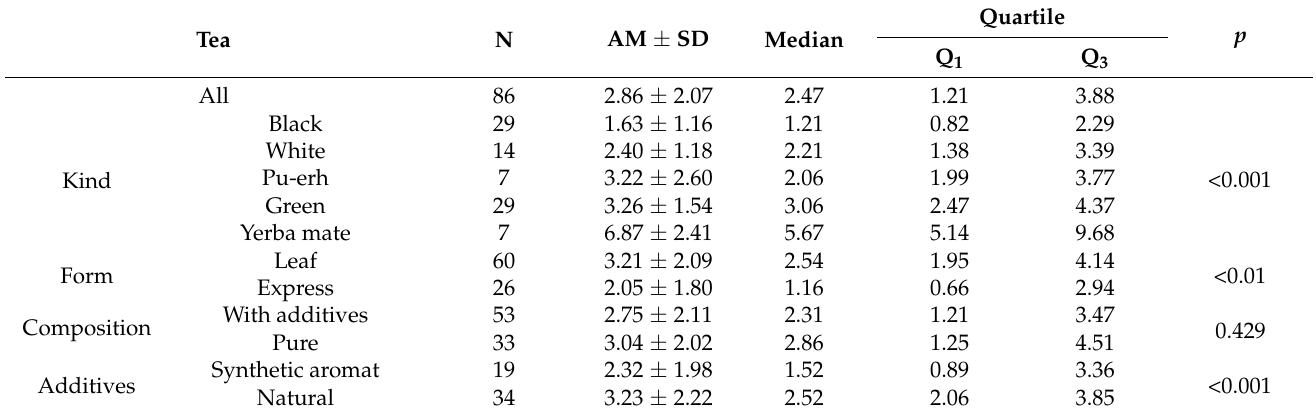
Table 1. The concentration of Hg in tea samples [ µ